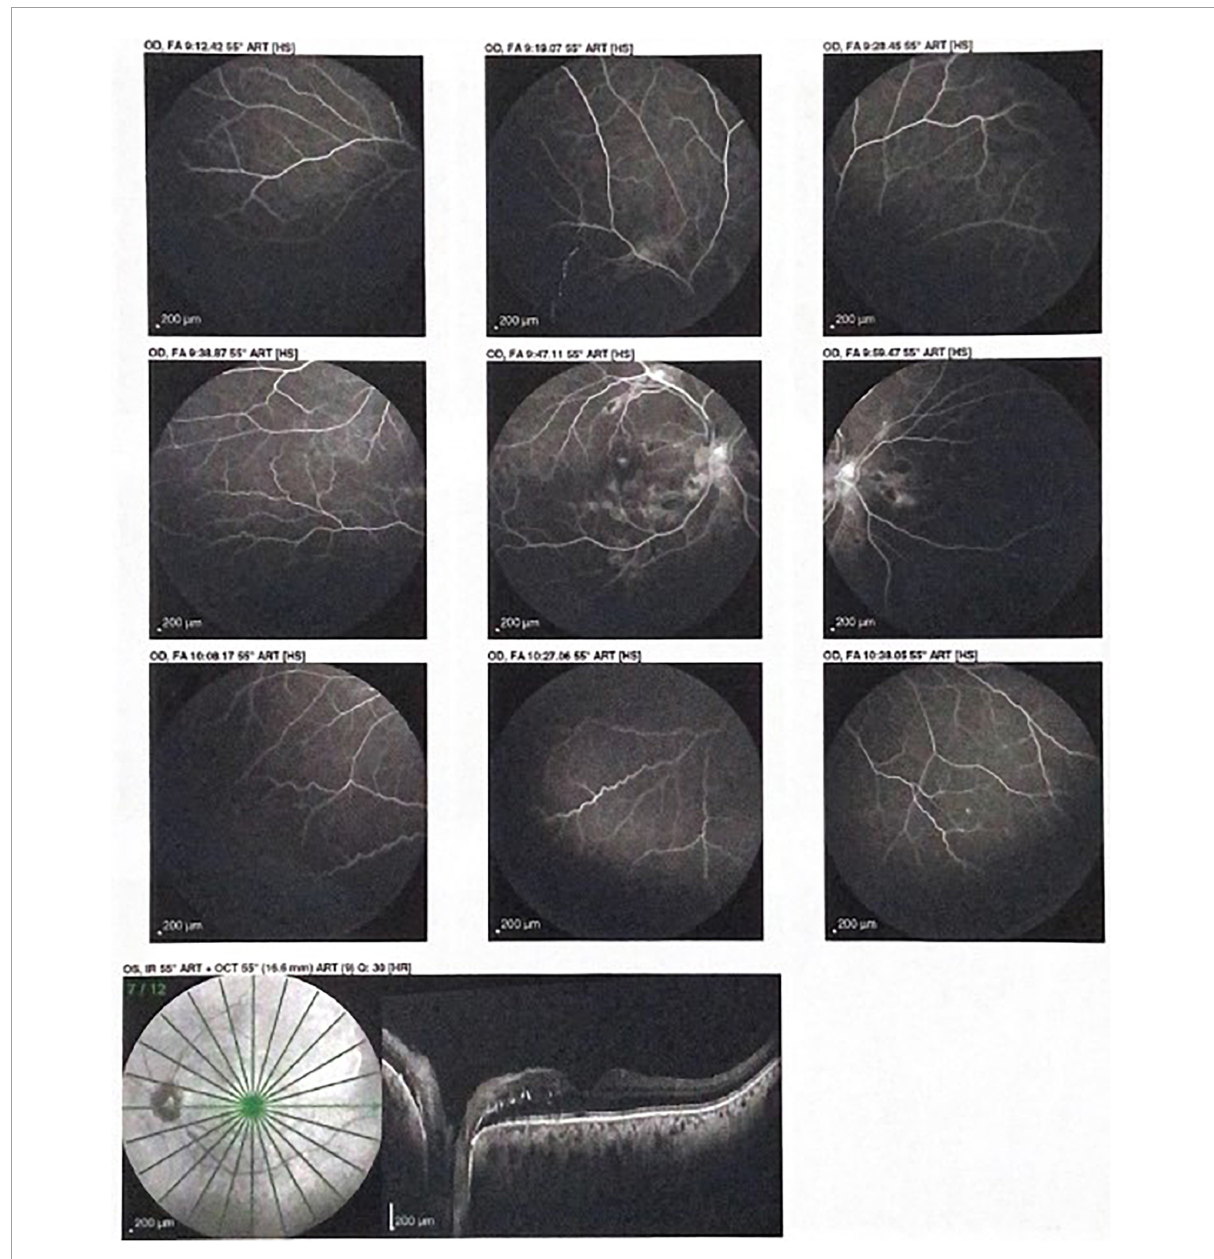
FIGURE3 Optical coherence tomography (OCT) showing hard intra-retinal exudates with